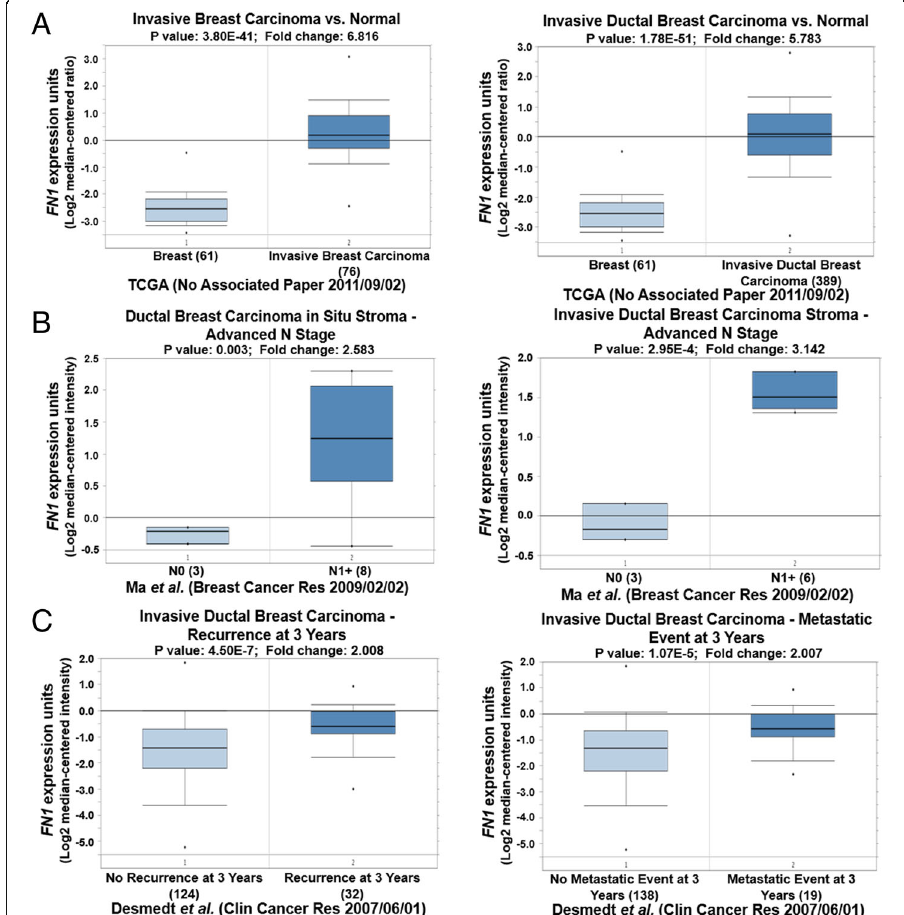
Fig. 5 Validation of FN1 expression in breast cancer using Oncomine datasets. a – High FN1 expression was observed in breast cancer compared with normal breast tissue. b – High FN1 expression was observed in high-grade or advanced-stage breast cancer. c – High FN1 expression was observed in breast cancer with recurrence or a metastatic event at 3